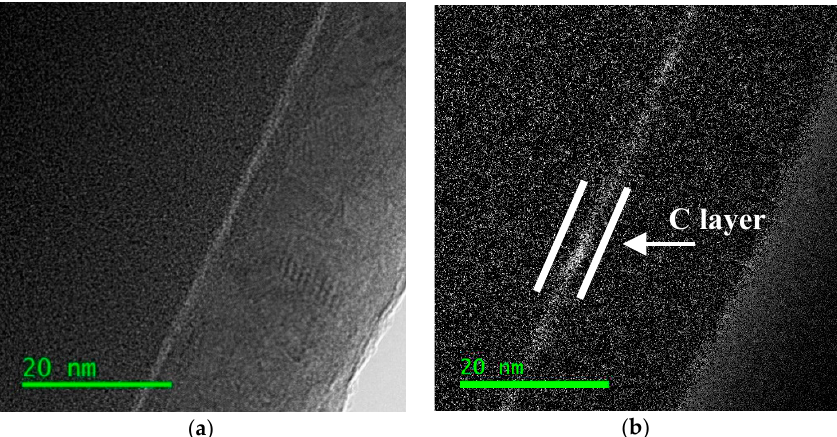
Figure 3. DNA ‐ coated SiO 2 cross section ( a ) in bright field, ( b ) carbon map. Detail of carbon signal from immobilized ssDNA ( white lines ).